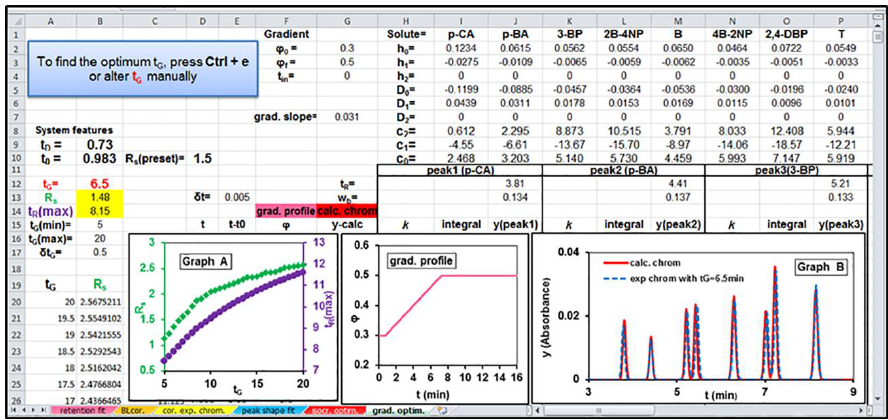
Figure 3. Screenshot of the MS Excel supplementary spreadsheet ‘grad. optim.’ used for separation optimization under single linear gradient conditions of solutes in eluent pH 3 modified with ACN. See the text for details.